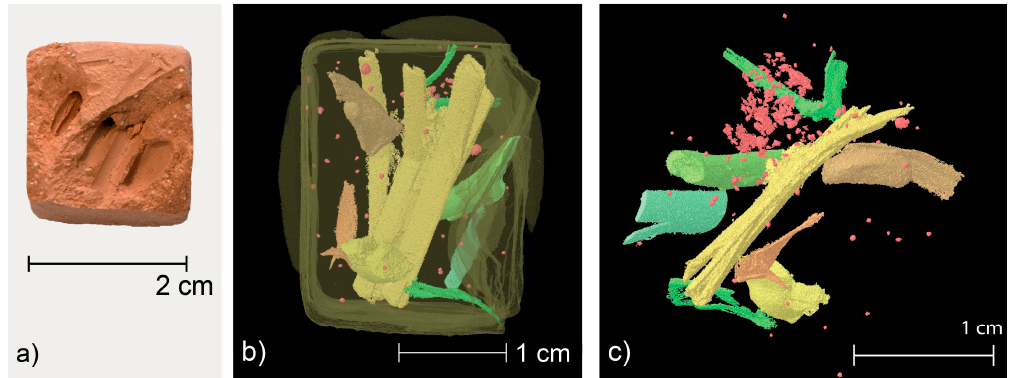
Figure 4. Standard II with organic components ( a ) impregnated with epoxy; ( b ) X-ray microtomography scan (top view); ( c ) detailed x-ray microtomography scan; visible phases: straw (yellow), heavy minerals, mainly magnetite (red), culm (green), hasks (turquoise), barley grains (beige), tooth fragment (dark brown).